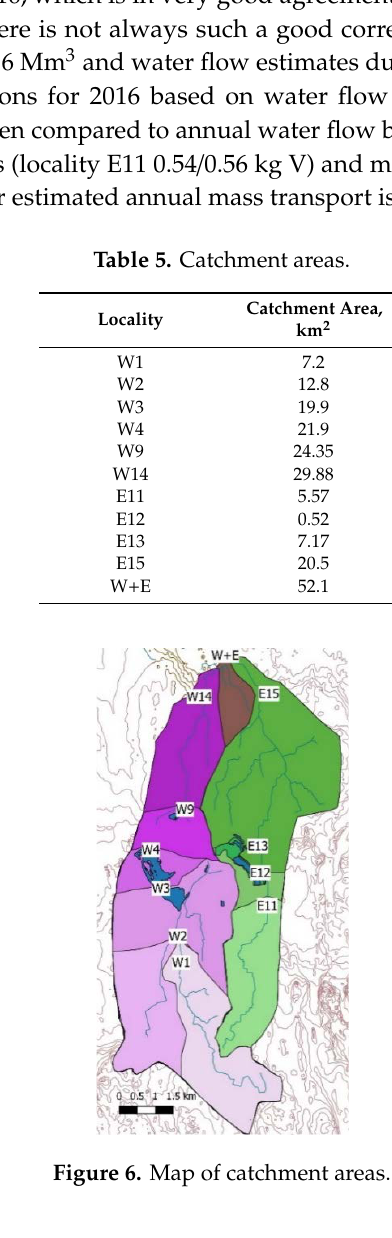
Table 4. Water flow, precipitation and temperature 2015–2019.